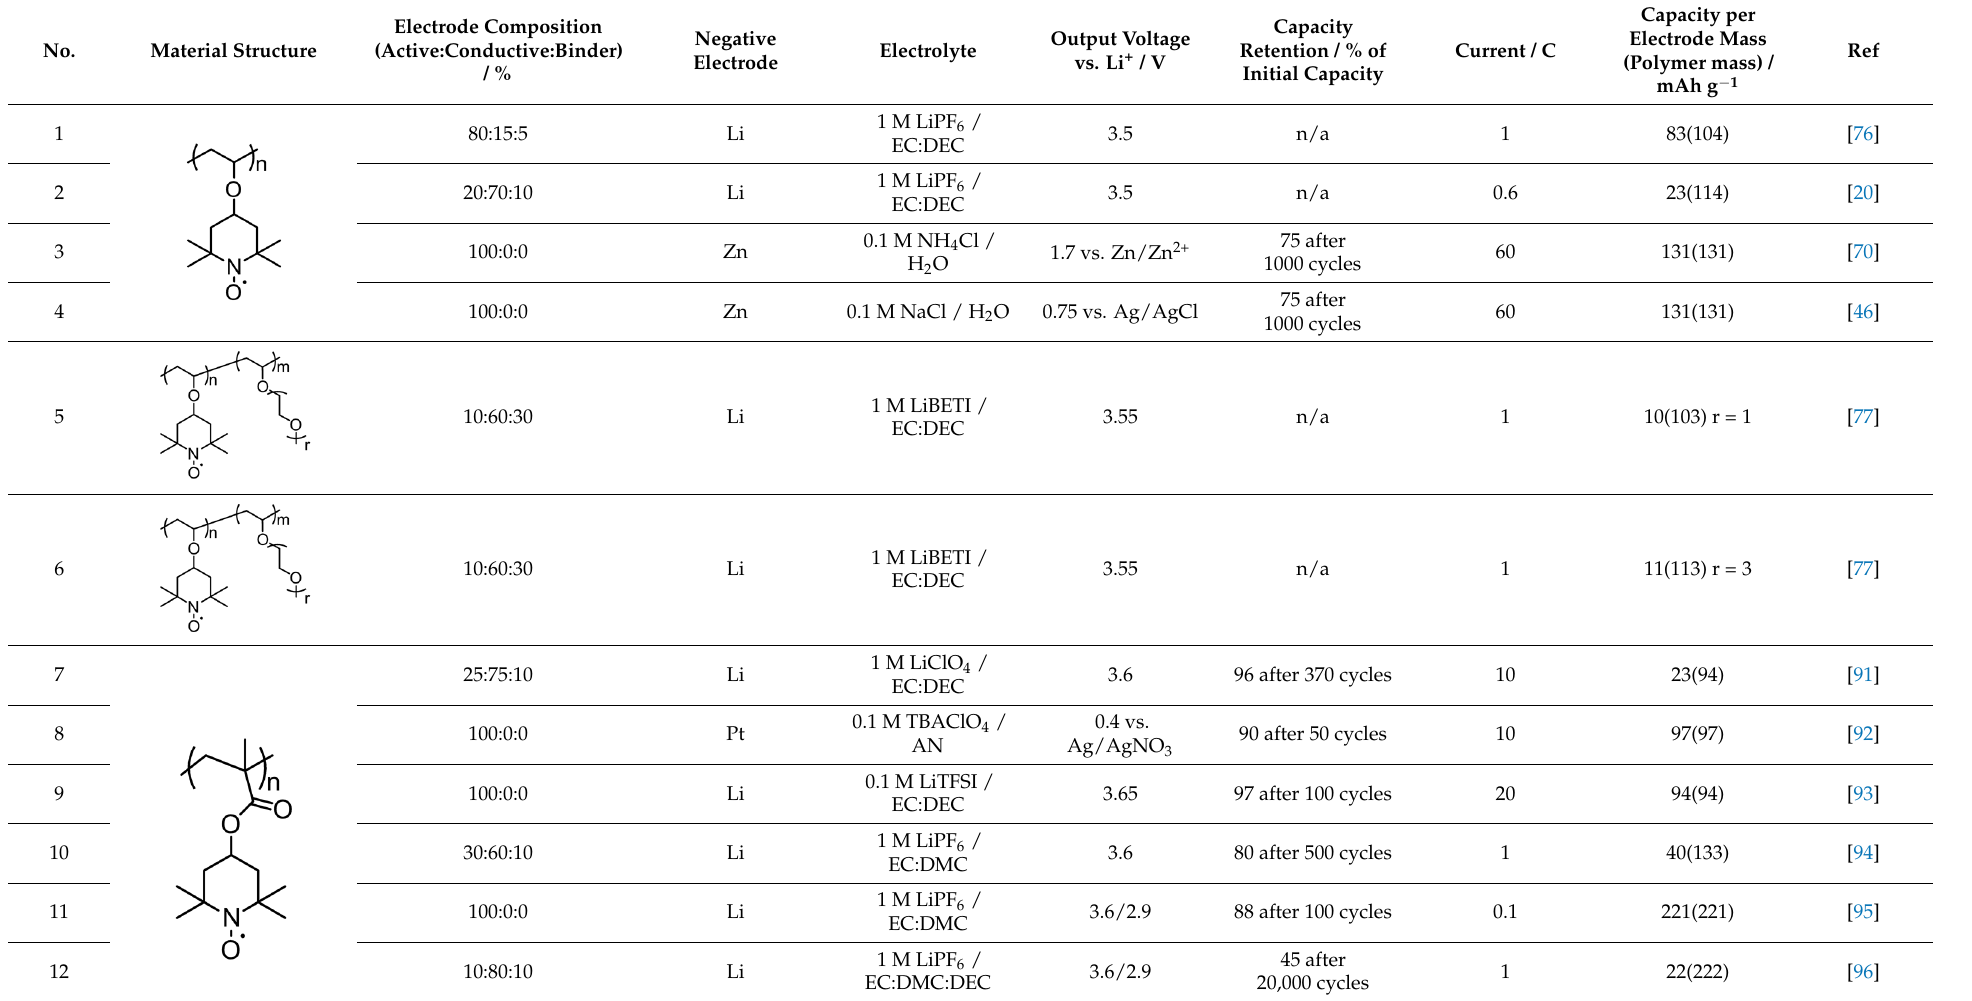
Table 1. Structures and energy storage performance of the TEMPO-containing polymers with non-conductive backbones.